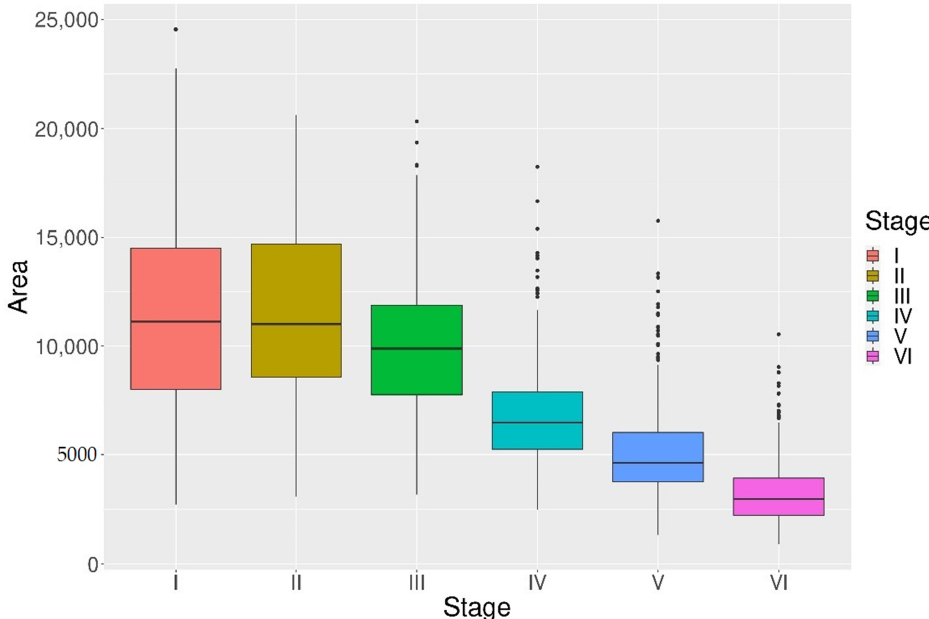
Figure 4. Mean area ( µ m 2 ) of postovulatory follicles (POF), measured on stored images by an image analysis technique per each POF stage (I to VI).